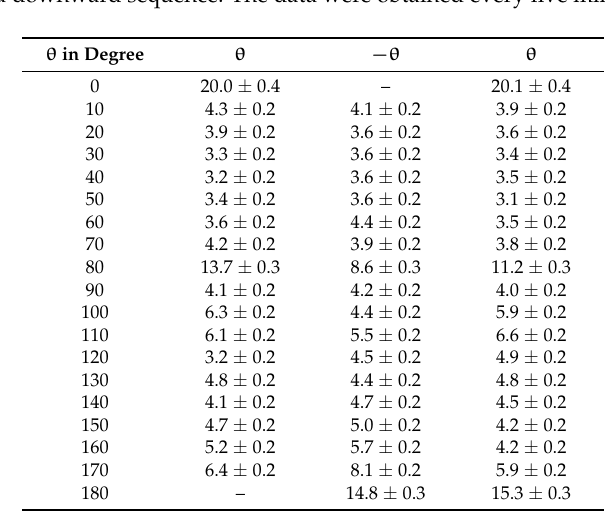
Figure 2. The θ -dependence of the superradiant Rayleigh scatterings of M4 γ at 662 keV in counts per second (cps) as a function of the 137 Cs source location of (5.4 cm, θ ). Data listed in Table 2 were taken every five minutes for a sequence from 0 to 540 degrees ( −θ means 360 − θ to demonstrate the mirror symmetry). Table 2. θ -dependence of superradiant Rayleigh in cps as a function of the source location of (r, θ ), where r is the radius and θ is the impinging angle, as shown in Figure 1. 2.5 mCi 137 Cs 3-mm point source was placed on the circle r = 5.4 cm radius; the second column of configuration was measured in the upwards sequence of −θ from the bottom number to the top number, while the other two columns were measured in a downward sequence. The data were obtained every five minutes.